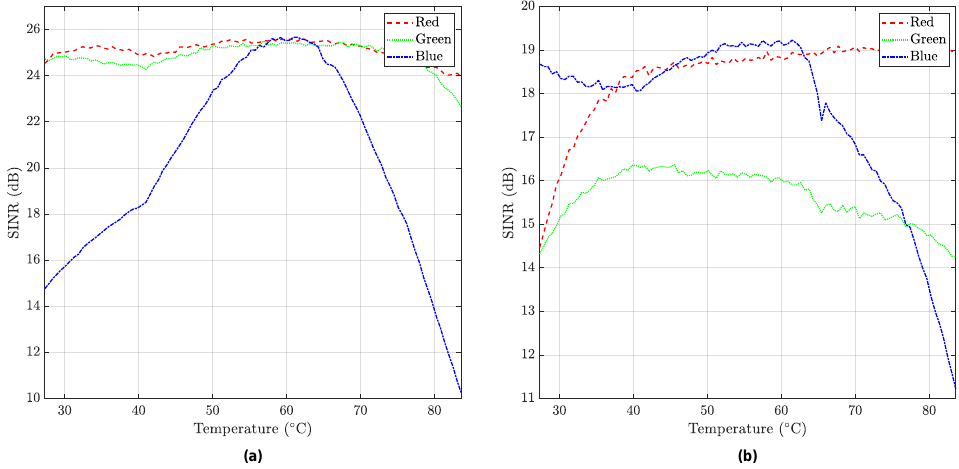
Figure 8. SINR at different temperatures, compensating the channel using the CSI corresponding to 60°C and with a high SNR value (30 dB). ( a ) Sony IMX249 and ( b ) Foveon X3. Dashed line, dotted line, and dash-dot line correspond to red, green, and blue,